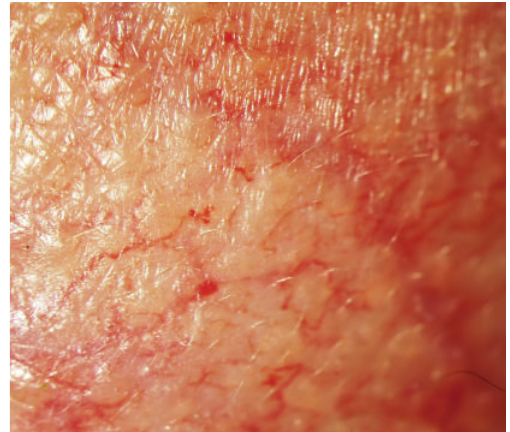
Figure 6: Higher magnification of microaneurysms seen with the severe form of vessels